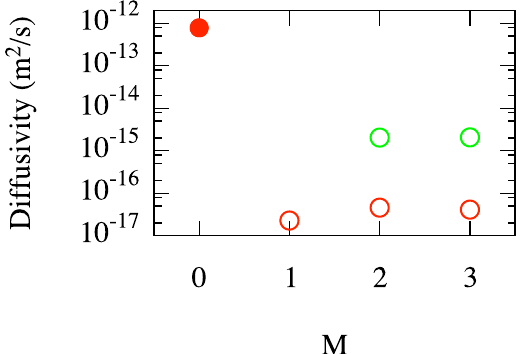
Figure 1. Diffusivity of low helium content V N He M complexes at T = 1000 K . Red: N = 1; Green: N = 2. Filled symbols correspond to estimates of the diffusivity, while open symbols are upper bounds at a 90% confidence level for cases where the complexes did not diffuse on accessible simulation timescales. The filled circle point represents a tungsten mono-vacancy containing no